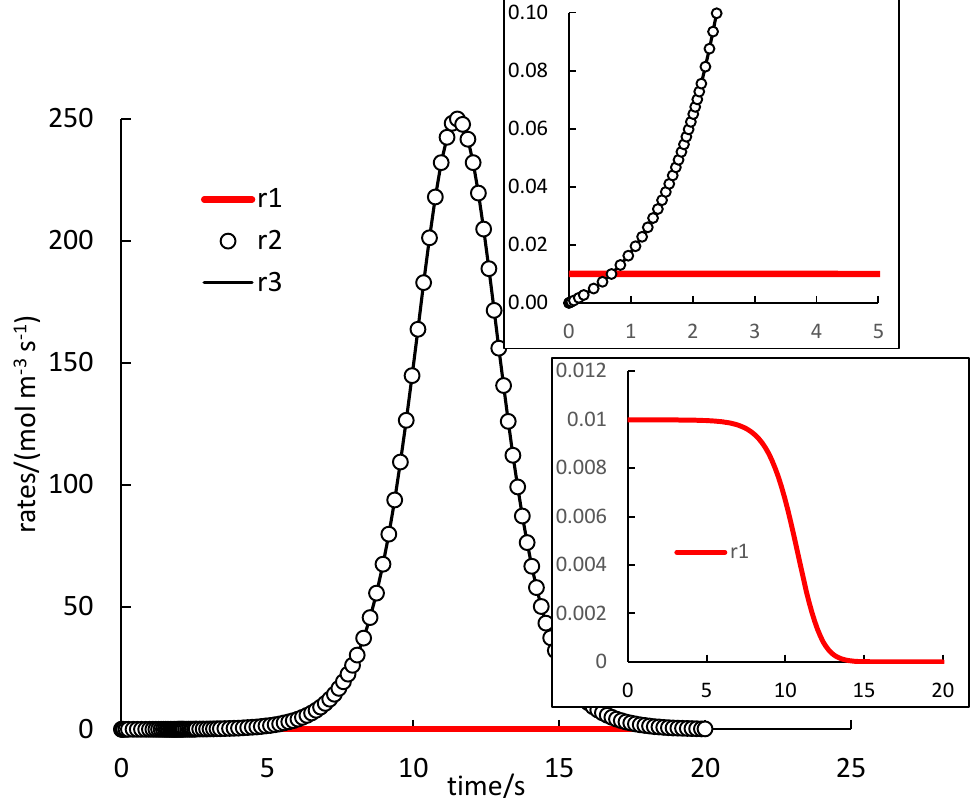
Figure 1. Modeled rate time profiles. Reaction scheme (R1), rates (1), batch system. Rate constants correspond to the black curve in Figure 1 in ref. [14]: k 1 = 10 − 8 , k 2 = 10 − 3 , k 3 = 10 4 (all m 3 mol − 1 s − 1 ). Insets show details in early times (upper) and r 1 profile (lower).